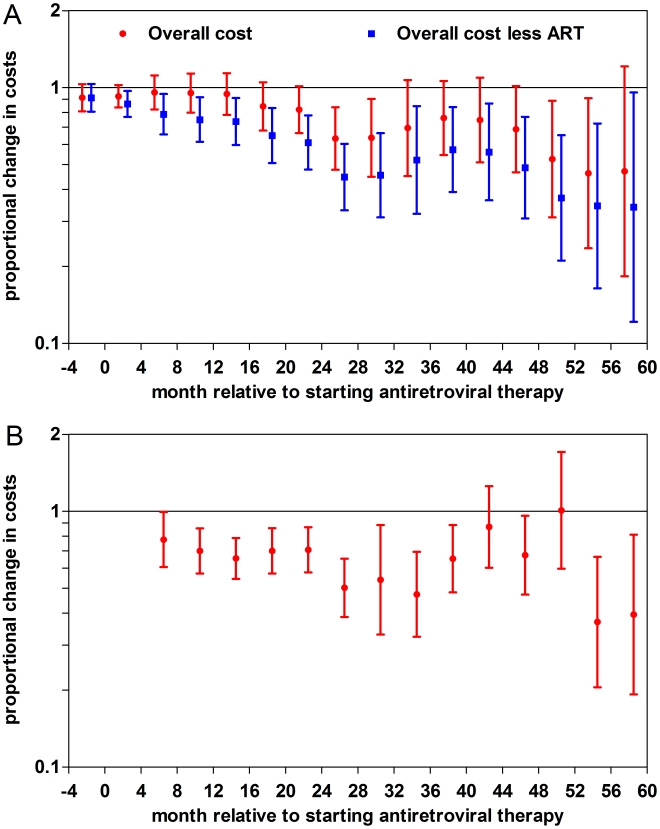
The proportional change in mean total costs associated with ART adherence with 95% confidence intervals.(A) The highest overall ART adherence quartile was compared with the lowest adherence quartile within each time interval (ART costs included and excluded) from 4 mo before starting ART to 60 mo on ART. (B) The highest lagged ART adherence group was compared with the lowest group (≥3 monthly versus ≤1 monthly refills in the previous 4-mo period) within each time interval from 4 mo before starting ART to 60 mo on ART.